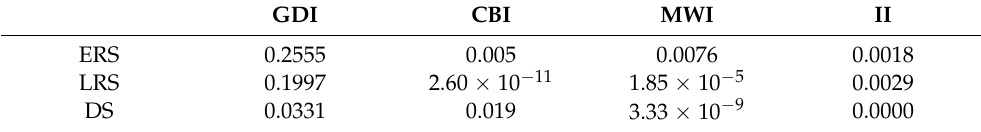
Figure 8. Regional trends (slope) per grid for the Galvez-Davidson Index (GDI) and individual sub-indices for the Column Buoyancy Index (CBI), the Mid-level Warming Index (MWI), and the Inversion Index (II). Table 5. List of p -values for regional (spatial) averaged trends per season for the GDI and